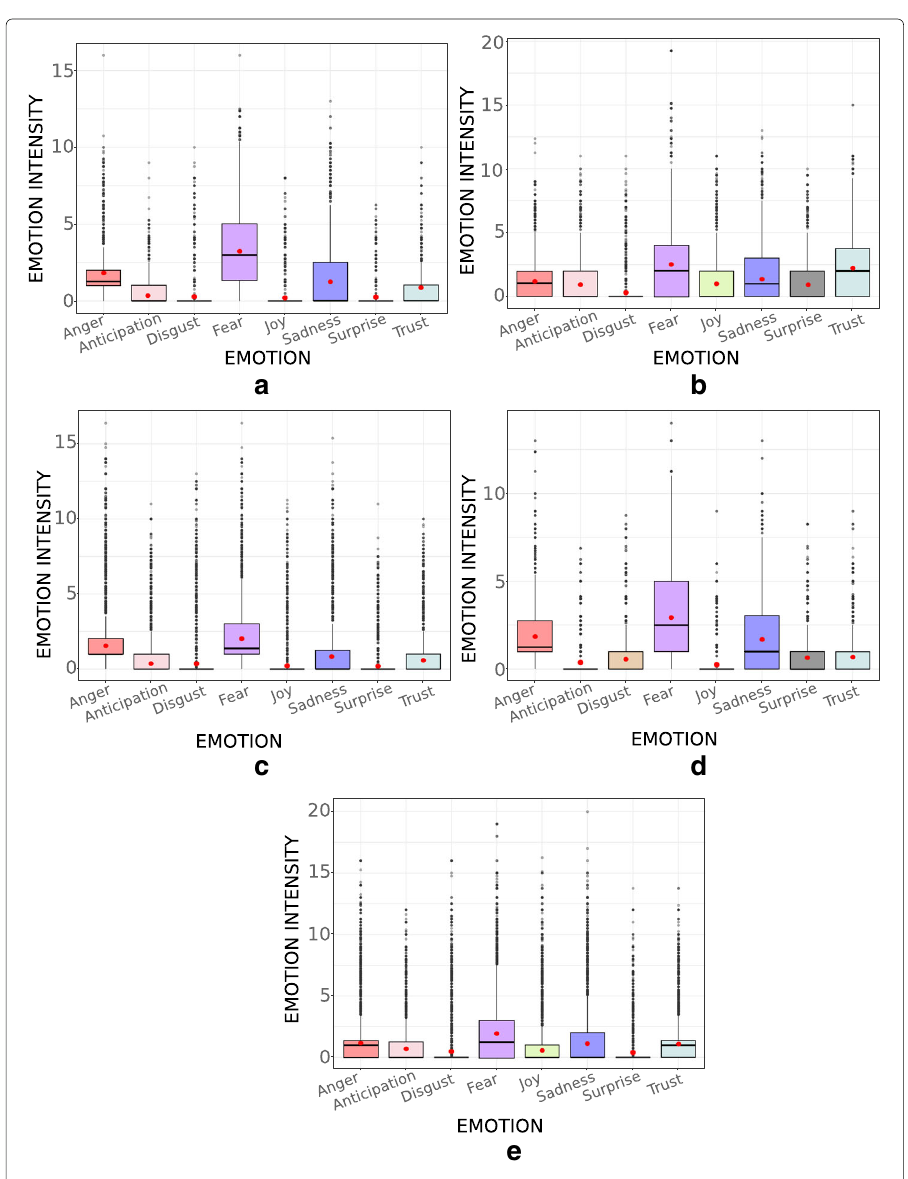
Fig. 4 Aggregated emotion intensity during the five crisis events. a Tehama County shooting b Trebes supermarket siege c YouTube shooting d Münster van attack e Santa Fe school shooting